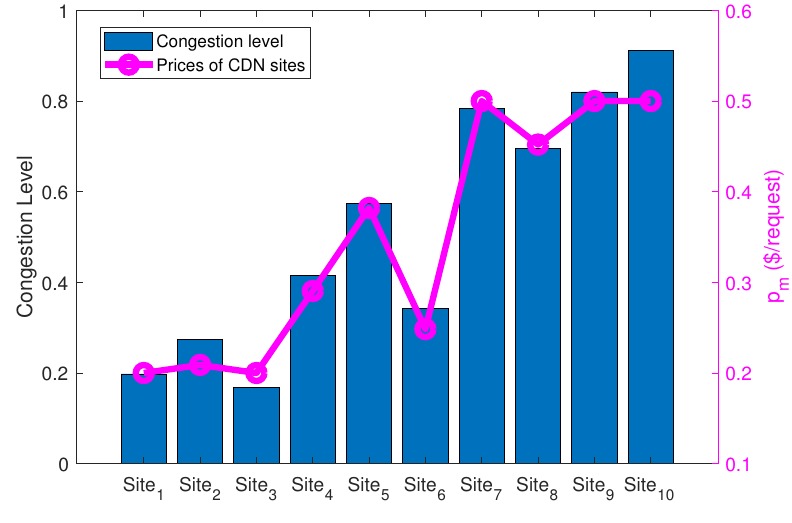
Figure 4. LDP Prices in Traffic Pattern